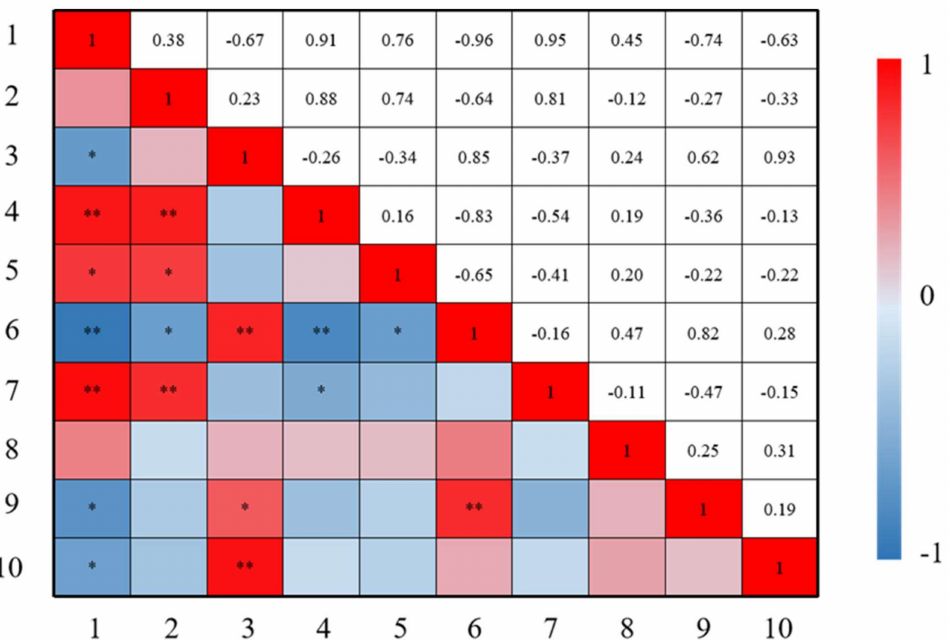
Figure 9. Correlation between culm traits and lodging index, bending strength in rice plants. Note: 1. lodging index; 2. plant height; 3. wall thickness; 4. the second internode length; 5. the third internode length; 6. bending strength; 7. bending moment; 8. cellulose content; 9. Si content; 10. cross sectional area. **, *: significant at p ≤ 0.01 and 0.05,